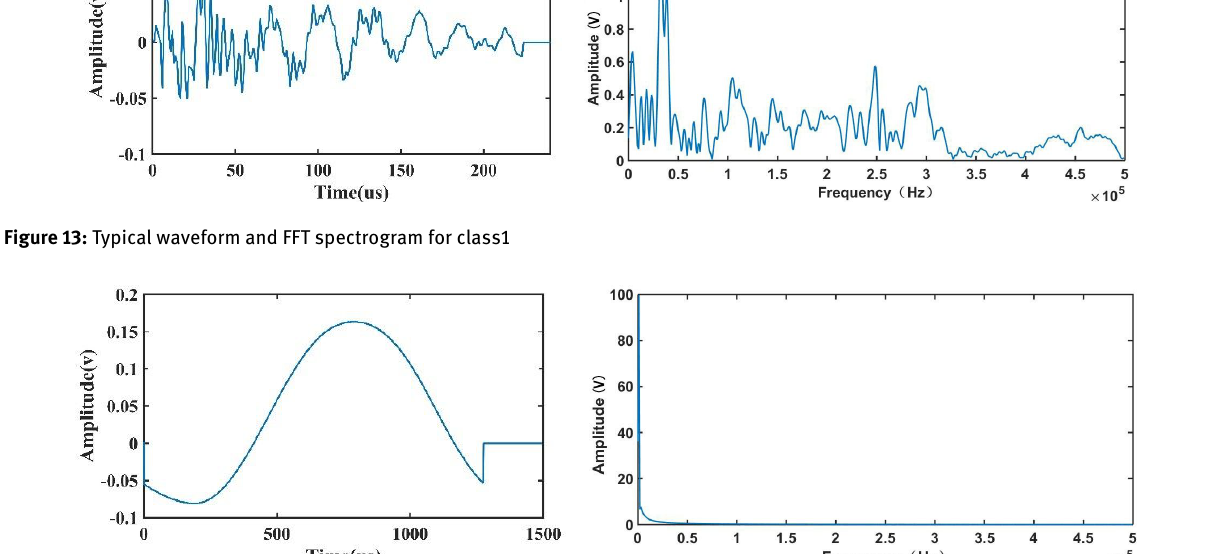
dle tensile process. It is obvious that the peak frequency of AE signals of fiber fracture is almost concentrated between